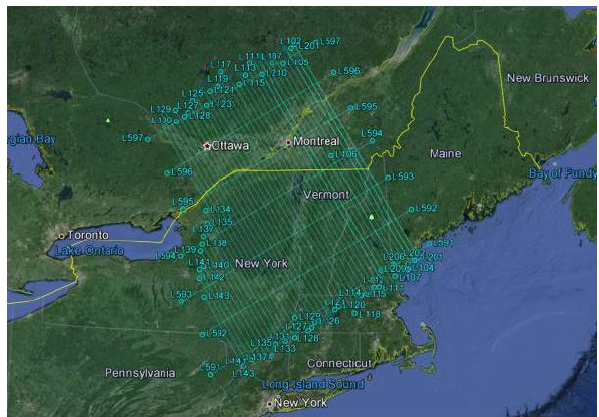
Figure 12: Data coverage of New Hampshire test area plotted in Google Earth